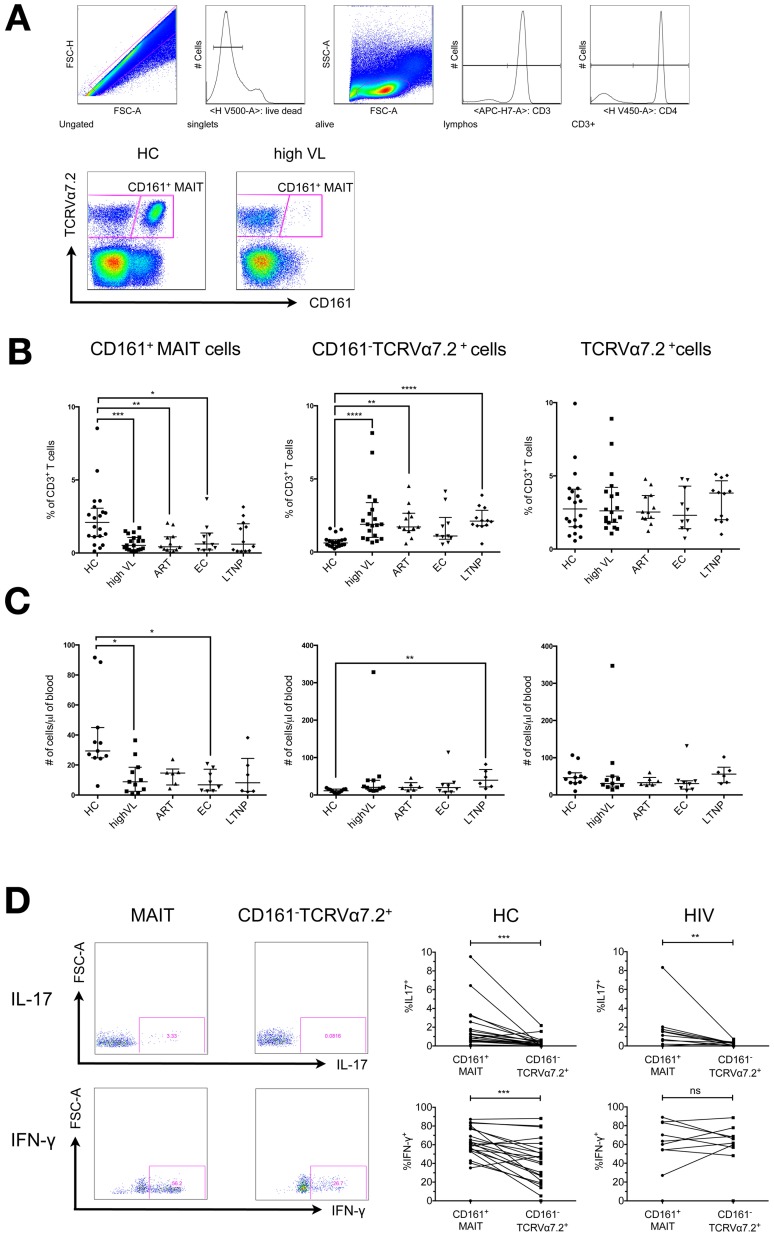
CD161+TCRVα7.2+ MAIT cells are severely reduced in the blood of HIV-infected patients.
A) Gating Strategy for CD161 and TCRVα7.2 based MAIT cell characterization in the CD4–CD3+T cell subset. All FACS analyses were performed on frozen PBMC samples. Depicted are representative plots from healthy control PBMCs (upper panel). Gating of the MAIT cell subsets comparing a healthy donor (HC) and an HIV patient (lower panel). B) Cumulative display of CD161+TCRVα7.2+ MAIT cell frequencies, CD161–TCRVα7.2+ and total TCRVα7.2+ cells in % of CD3+ T cells comparing PBMC samples derived from healthy controls (HC n = 20), untreated patients with high viral loads (high VL n = 20), patients receiving antiretroviral treatment for a at least one year (ART n = 12), elite controller (EC n = 10) and patients with very low viremia and slow progression (<5000 copies/ml; LTNP n = 12). C) Absolute MAIT cell counts, CD161–TCRVα7.2+ and total TCRVα7.2+ cells per µl peripheral blood, calculated based on absolute CD3+ T cell counts (available for 12 HC, 11 high VL, 6 ART, 8 EC and 6 LTNP). All groups were tested for normal distribution with the Kolmogorov-Smirnov test and were compared by the adequate test, ANOVA followed by Tukey's multiple comparisons test or Kruskal-Wallis followed by multiple comparison test, respectively. P-values smaller than 0.05 were considered significant, where *, ** and *** indicate p-values between 0.01 to 0.05, 0.001 to 0.01 and 0.0001 to 0.001, respectively. Bars and lines indicate median, 25% and 75% quartiles. D) Representative FACS plots and the percentages of cells that produce the cytokines IL-17 and INF-γ upon stimulation with PMA/ionomycin among MAIT cells and CD161–TCRVα7.2+ cells are shown. PBMC samples derived from healthy donors (n = 22) and HIV-infected patients (ART treated and untreated with high viral loads, n = 10) were analyzed. Asterisks indicate the results of Wilcoxon matched-pairs signed-rank tests.